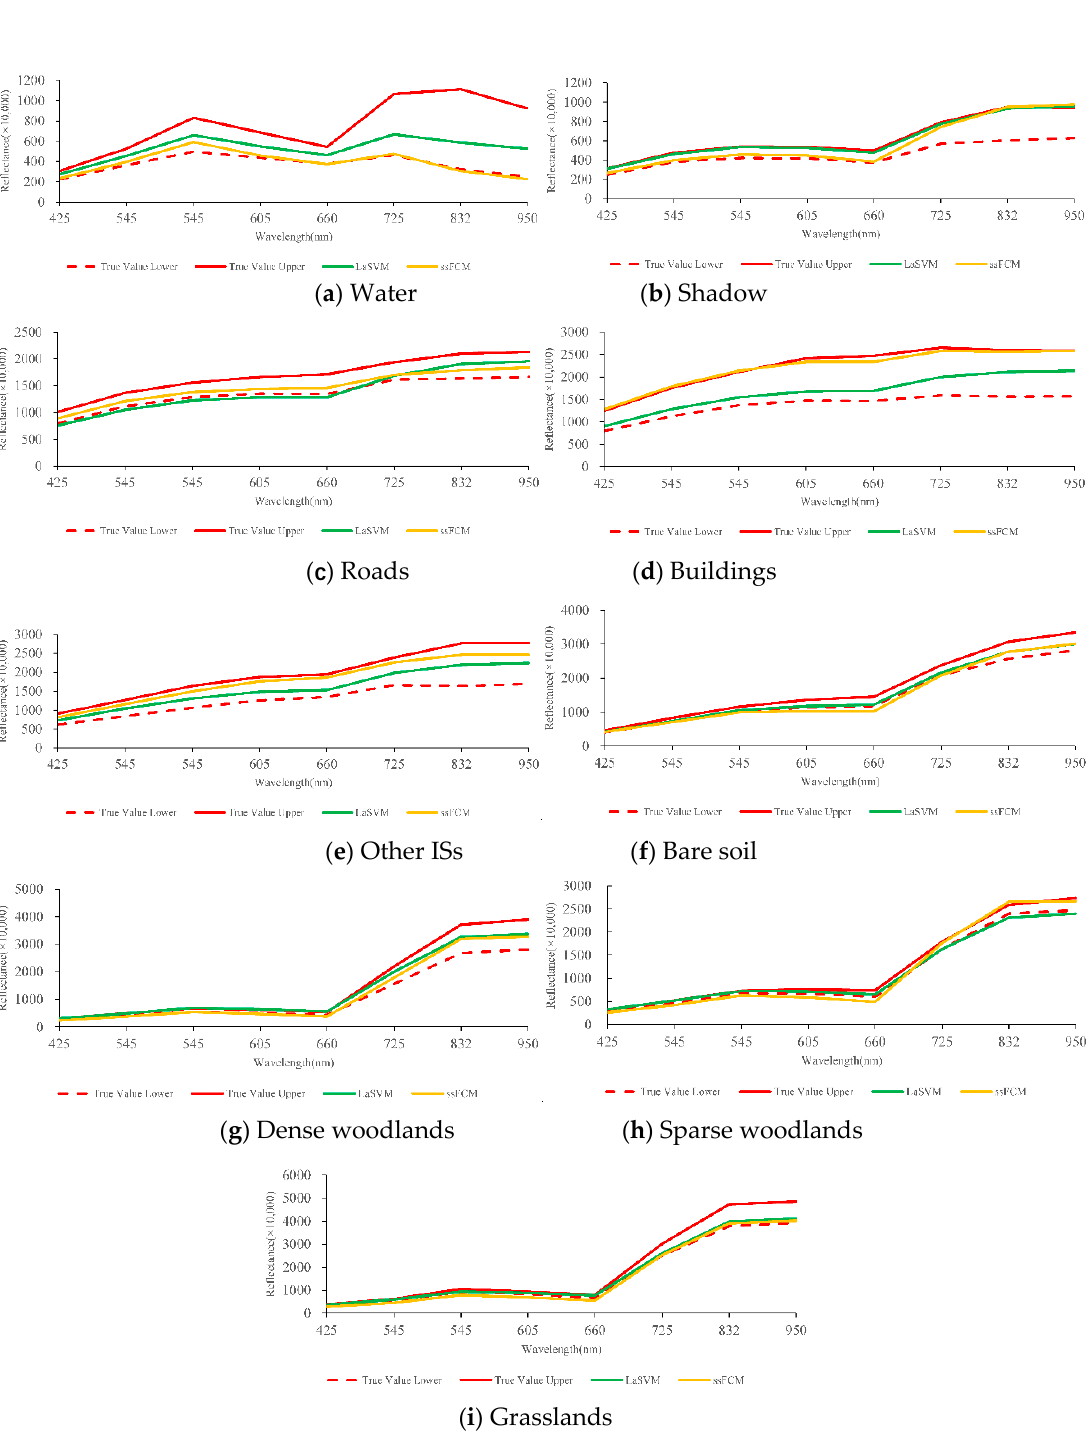
Figure 13. The spectral curves of true value and the single-valued spectral curves modeled by ssFCM and LaSVM (wavelength: nm). The x-axis is the wavelength, and the y-axis represents the reflectance for a scale factor of 10,000.